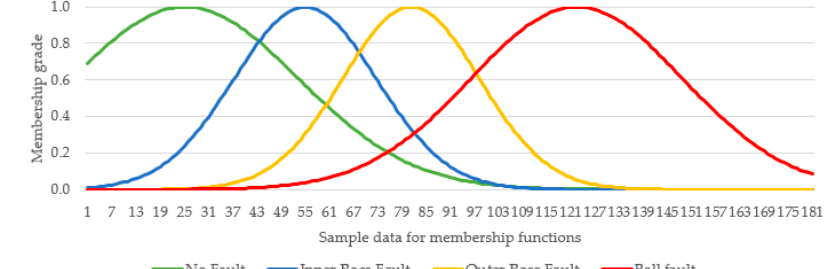
Table 5. Sample membership values of feature data for different fault classes. Figure 8. Membership functions for the statistical features using FCM.